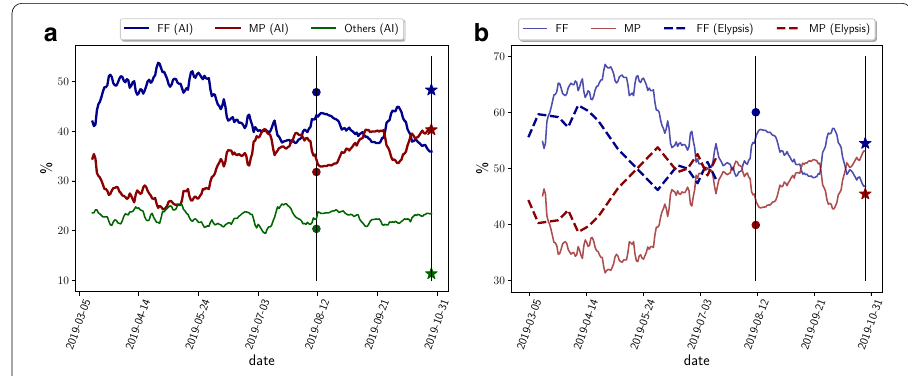
Fig. 10 a Results from Model 0 . Instantaneous results of the AI Model 0 obtained in a moving window of w 14 days. Vertical lines are (from the left to the right) the day of the primaries and general elections = respectively. The circles represents the official results for the primaries while the stars are those for the general election. b Results from a compared with polls from Elypsis. Thick continuos lines represent AI results from Model 0 (instantaneous) while dashed line represent the Elypsis predictions. The instastaneous model does not predict the results of the elections. Instead, we consider the cumulative predictions in Figs. 11 and